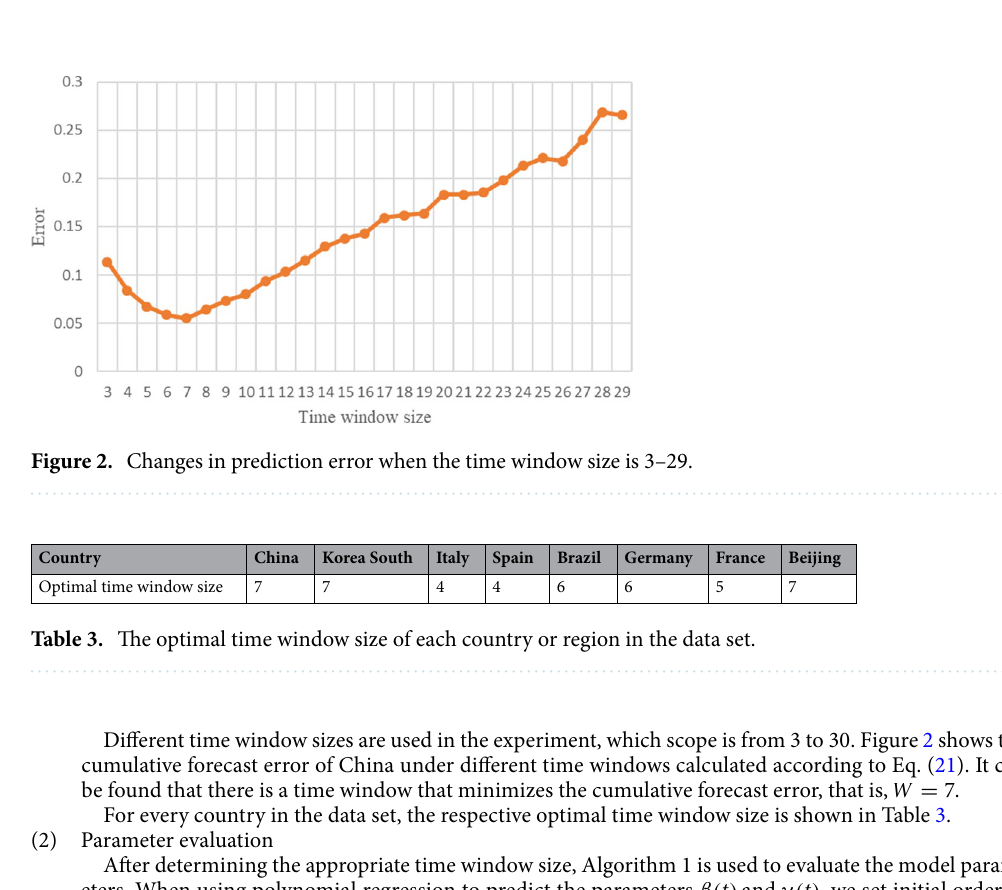
Table 2. Data set description.